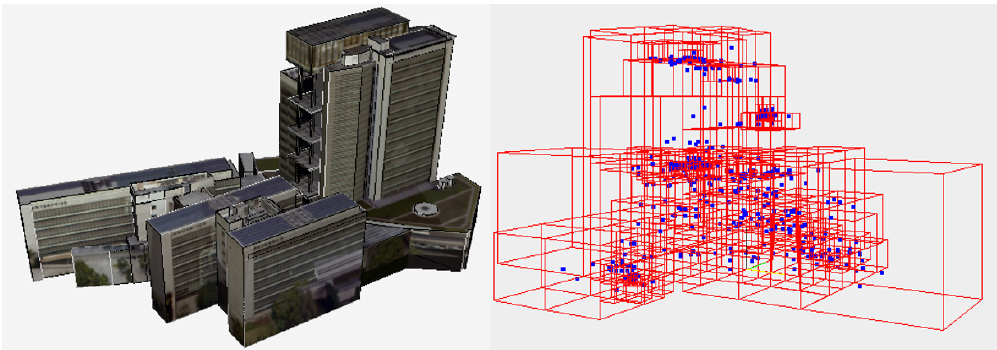
Figure 10. A building model and its octree.